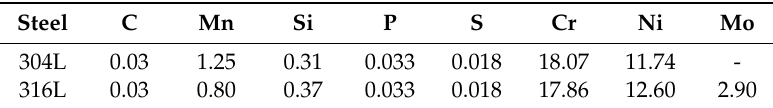
Table 1. Chemical composition of steels /wt.